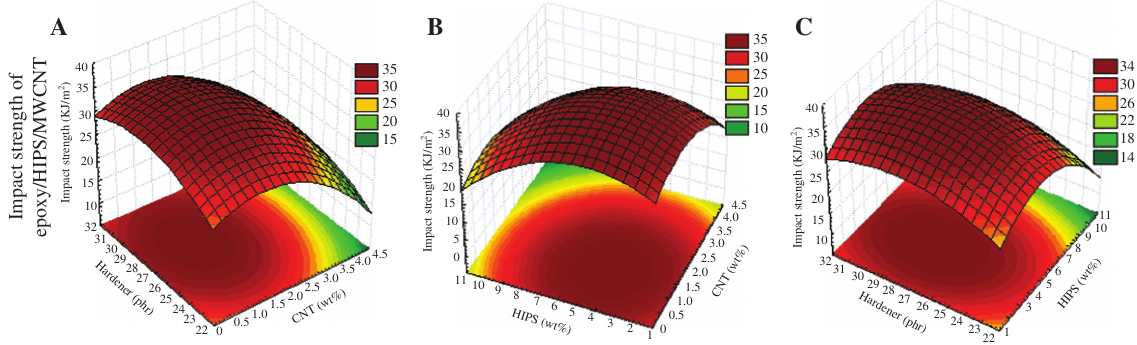
Figure 9 Three-dimensional plots of impact for (A) HIPS (4.5 wt%), (B) hardener (28 phr) and (C) MWCNT (1.3 wt%).